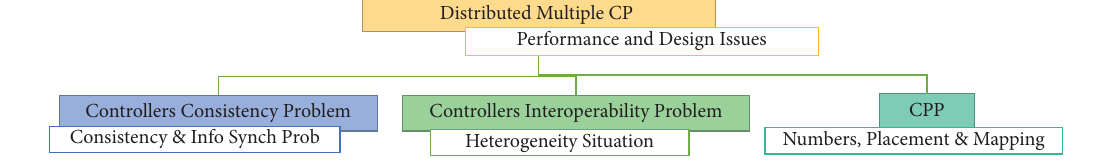
Figure 6: Distributed control plane design challenges.